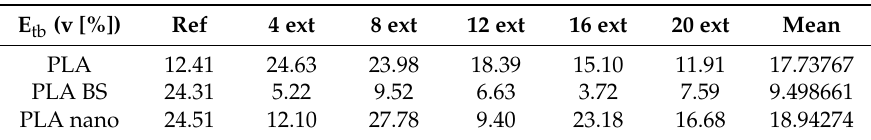
Table 3. Dispersion of elongation at break values. Elongation at break (E tb ), v [%] Coefficient of variation in %.